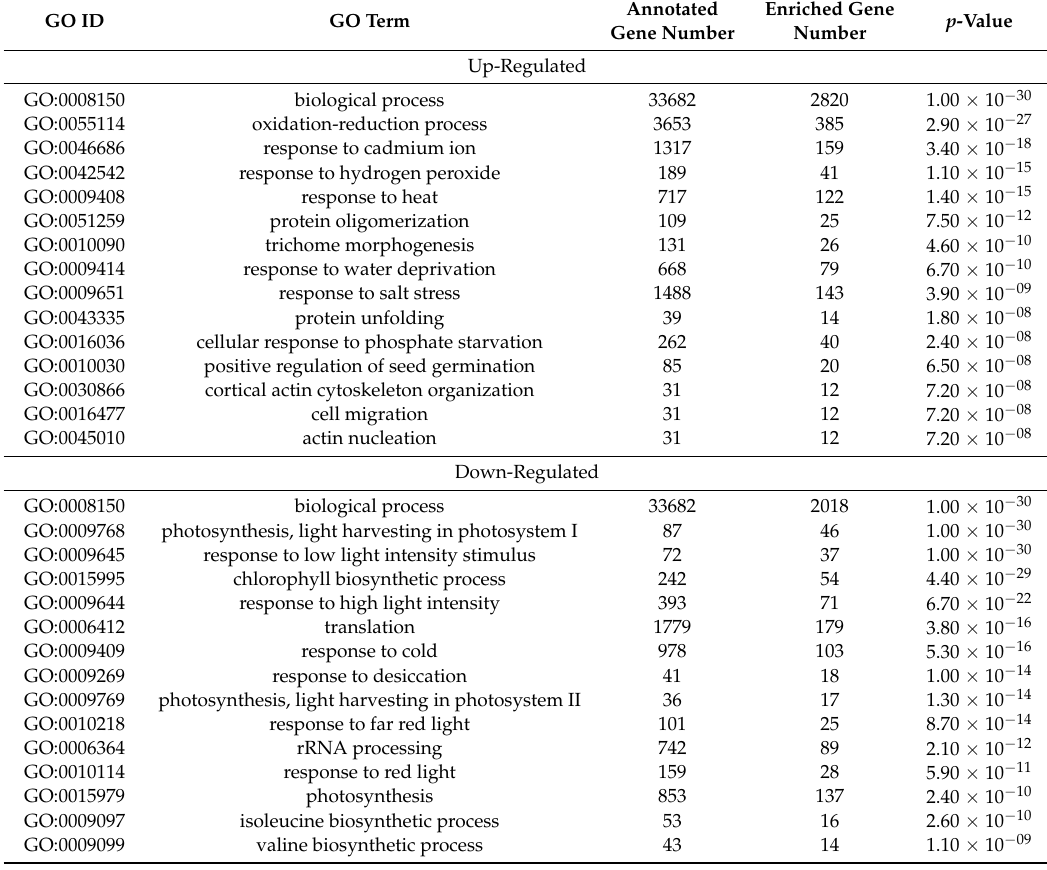
Table 3. Top30 biological processes enriched by the up- and down-regulated